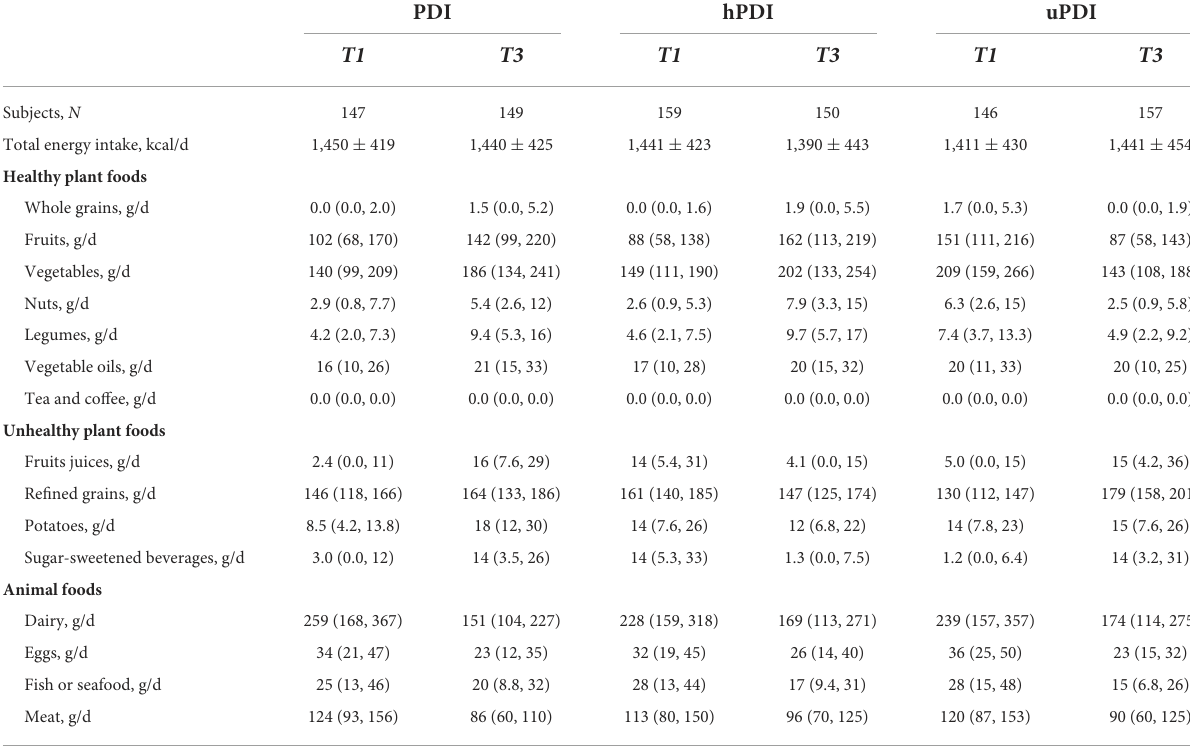
TABLE 2 Dietary information of intake of different foods in our